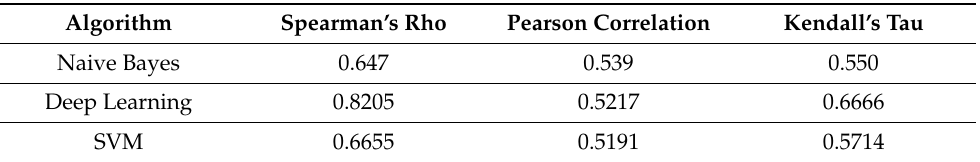
Table 3. The results of validation of the estimated damage map from Naive Bayes, SVM, and deep learning at the county